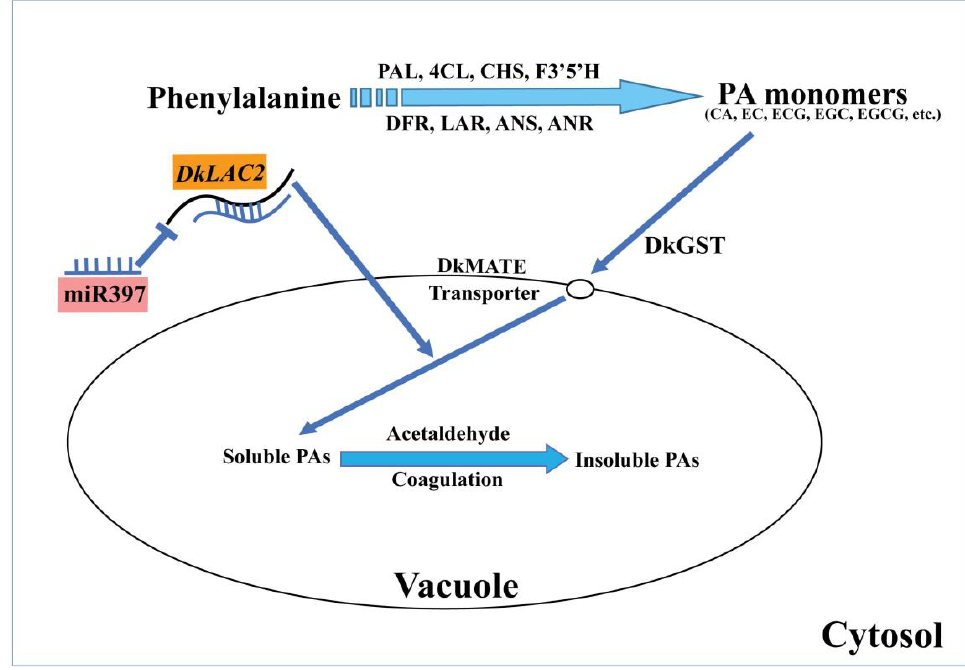
Figure 7. A working model of DkmiR397 and DkLAC2 regulates PA biosynthesis in C-PCNA per-